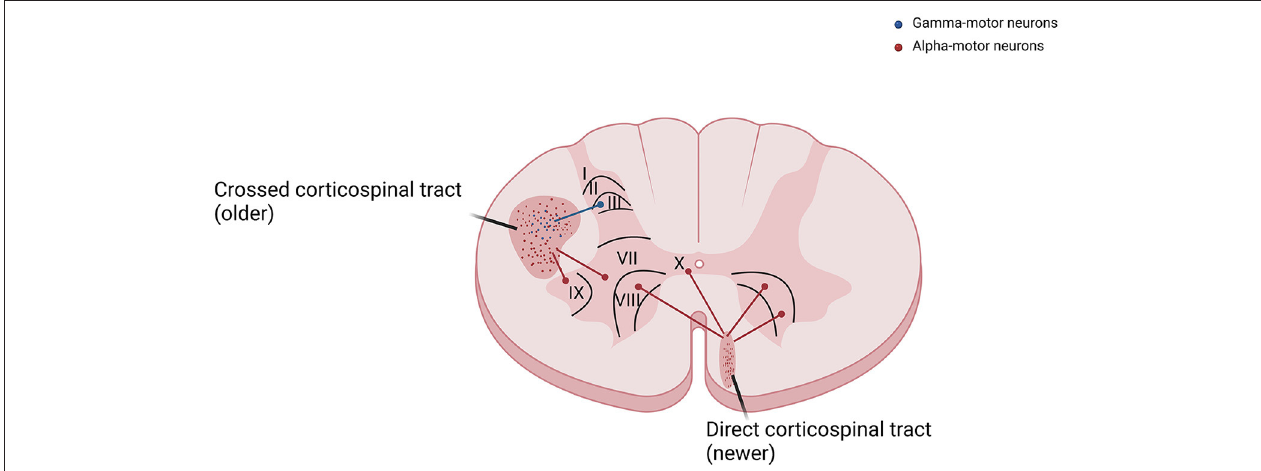
FIGURE 2 | The corticospinal tract is divided into crossed corticospinal tract and direct corticospinal tract. Fibers that reach gamma-motor neurons, responsible for the control of the stretch reflex, are predominantly part of the phylogenetically older lateral or cruciate corticospinal tract. Fibers that reach alpha-motor neurons in the laminae IX and X of spinal cord anterior horns, responsible for the control of voluntary movements, are predominantly part of the newer anterior corticospinal tract.